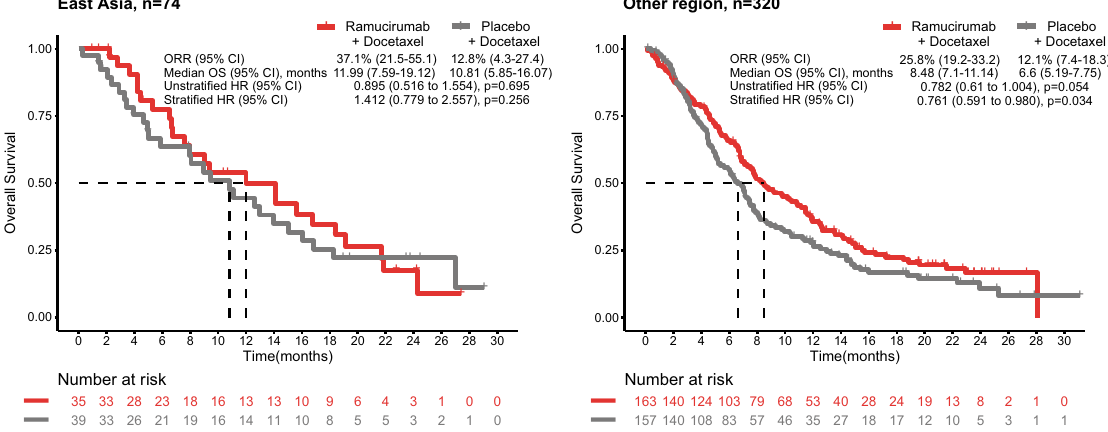
Fig. 7 Molecular subtype association with mean angiogenesis/immune signature scores and geographical region. a , b Mean of angiogenesis ( a ) and immune ( b ) signature scores, by geographic region, relative to molecular subtypes of the Decipher GSCv1 and ConsensusMIBC classi fi cation schemes in the TR2 population ( n = 394 samples from n = 394 participants in the TR2 population). Decipher GSCv1 subtype prevalence ( n /group; East Asia/Other): Luminal ( n = 131; n = 30/ n = 101), Luminal In fi ltrated ( n = 55; n = 6/ n = 49), Basal ( n = 150; n = 28/ n = 122), Claudin Low ( n = 58; n = 10/ n = 48). ConsensusMIBC subtype prevalence ( n /group; East Asia/Other): Luminal Papillary ( n = 97; n = 24/n = 73), Luminal Non-Speci fi ed ( n = 39, n = 4/ n = 35), Luminal Unstable ( n = 61; n = 7/ n = 54), Stroma-rich ( n = 75; n = 14/ n = 61), Basal/Squamous ( n = 114; n = 24/ n = 90), Neuroendocrine-like ( n = 8; n = 1/ n = 7). For boxplots, center line represents median, box hinges represent fi rst and third quartiles, whiskers represent minimum and maximum within 1.5x interquartile range, and red marker is mean. c Kaplan – Meier curves representing OS probability in ramucirumab + docetaxel or placebo + docetaxel arms based on geographic region. ORR, median OS, and strati fi ed/unstrati fi ed HRs are shown. Two-sided Wald test was used in Cox regression. p -values before BH-adjustment are shown in fi gures. p -values after BH-adjustment are shown in Supplementary Table 1. Strati fi cation was based on geographical region, baseline ECOG PS, and visceral metastases. TR2 population ( n = 394 participants) is shown; there were n = 74 participants included in the East Asia subgroup and n = 320 participants included in the other regions subgroup. The proportional hazard assumption was not violated in any instance. Source data are provided as a Source Data fi le.BH, Benjamini-Hochberg; Ba/Sq, Basal/Squamous; CI, con fi dence interval; ECOG PS, Eastern Cooperative Oncology Group Performance Status; HR, hazard ratio; Lum NS, Luminal Non-Speci fi ed; Lum Pap, Luminal Papillary; Lum U, Luminal Unstable; n, number of participants; NE-like, Neuroendocrine-like; ORR, objective response rate; OS, overall survival; TR, translational